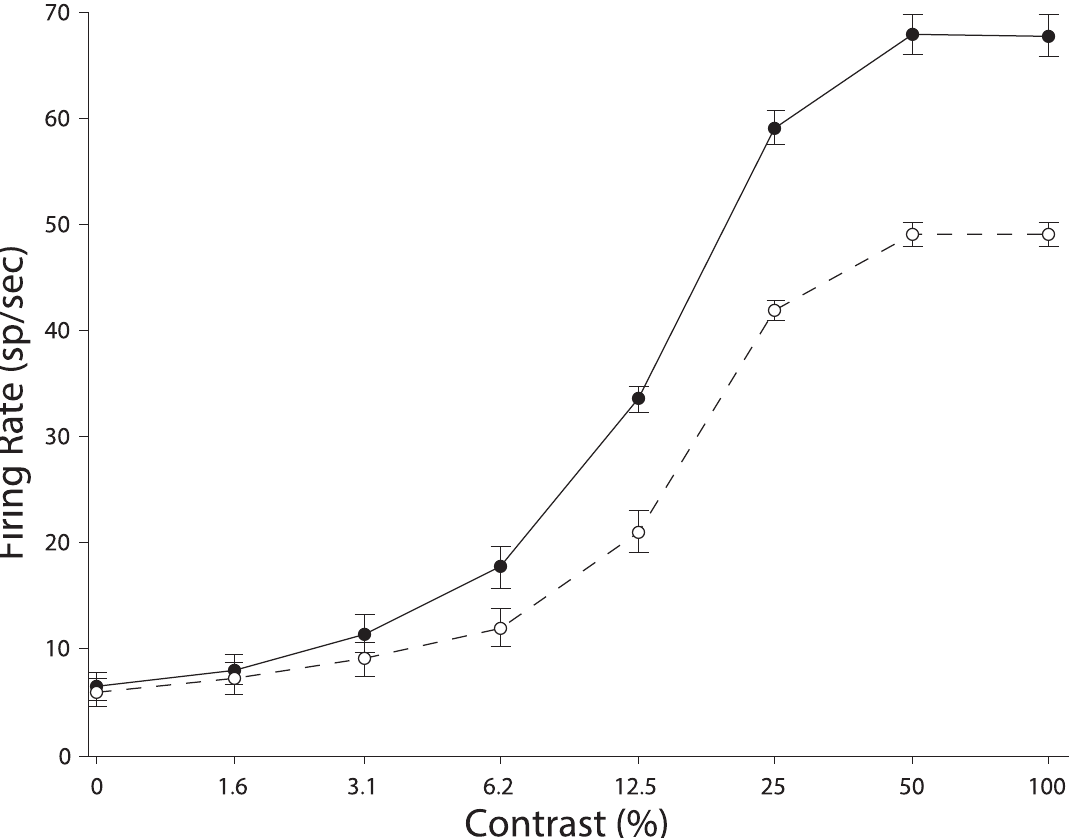
Figure 8. Population average contrast-response functions for 200 model neurons. Vertical scaling of responses with attention to the preferred stimulus show a predominately response gain effect (See Fig. 2C in [5]). The solid and dashed lines are the best fitting function when attention was directed to the preferred and non-preferred stimulus respectively. Error bars are SE values.